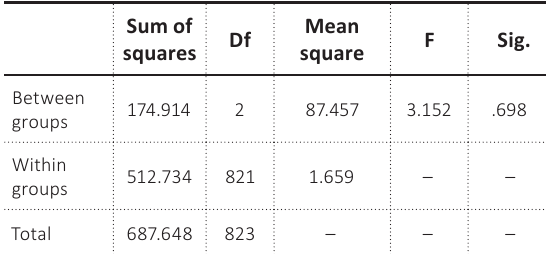
Table 2. ANOVA test for H2